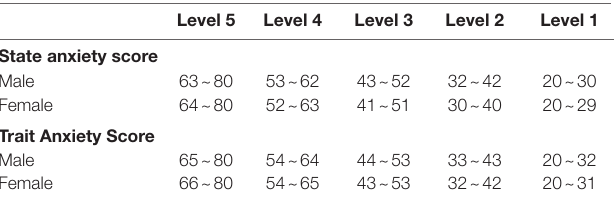
TABLE 1 | Stage table of